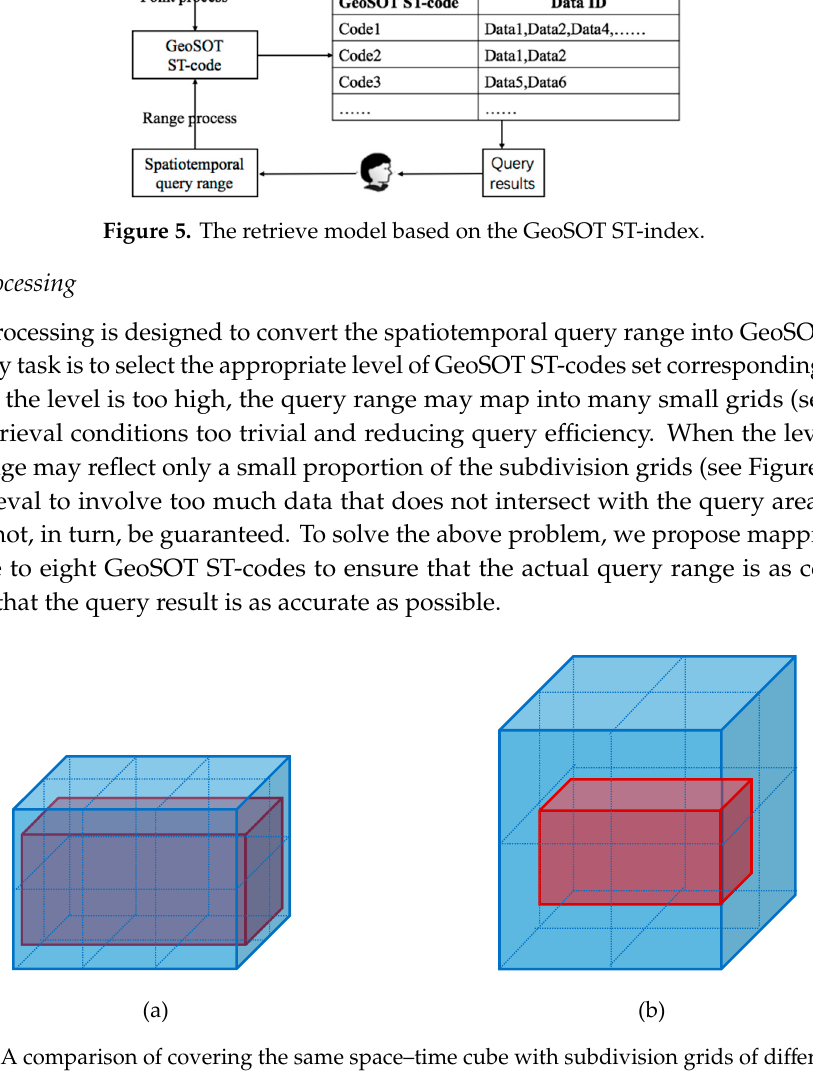
Figure 6. A comparison of covering the same space–time cube with subdivision grids of different sizes.